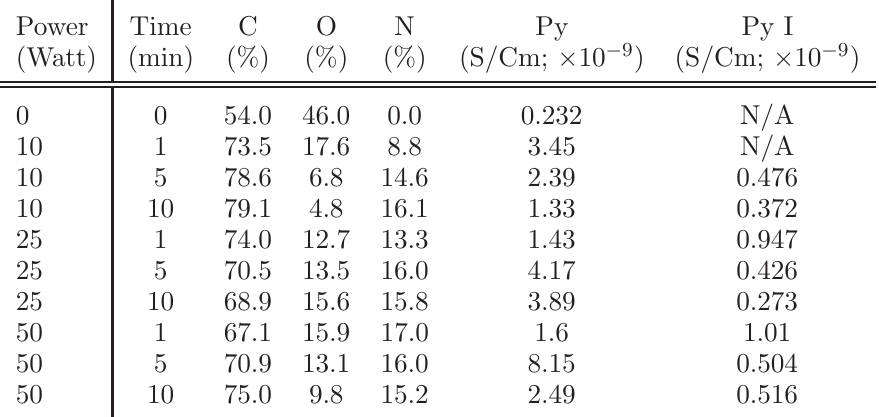
Table 2 Comparative electrical conductance of iodine doped (PyI) and non-doped (Py) pyrrole plasma treated